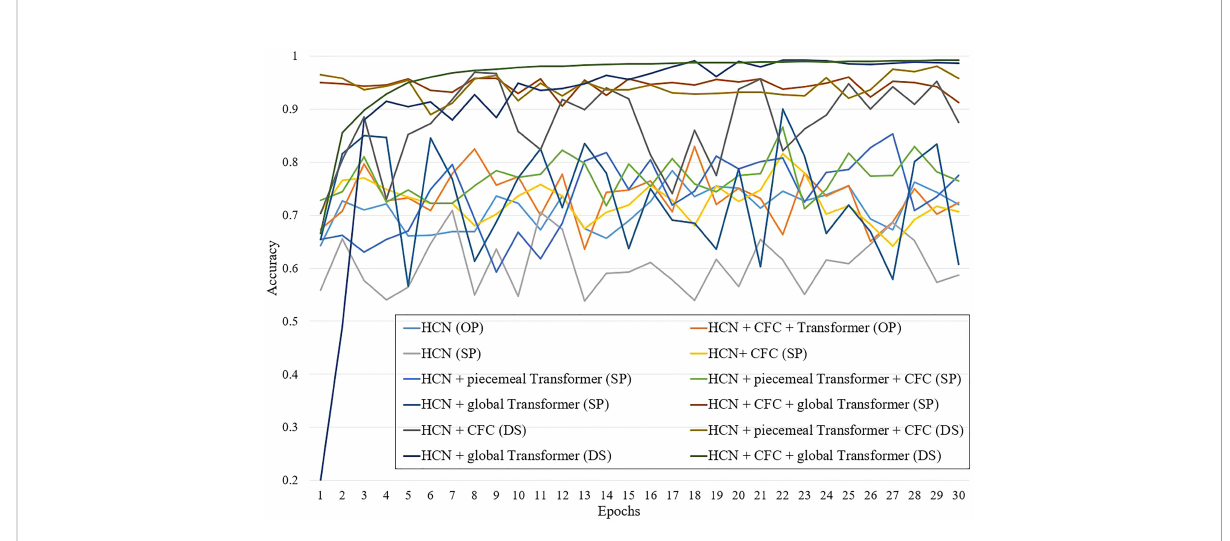
FIGURE 3 Validation Accuracy Curves of Ablation